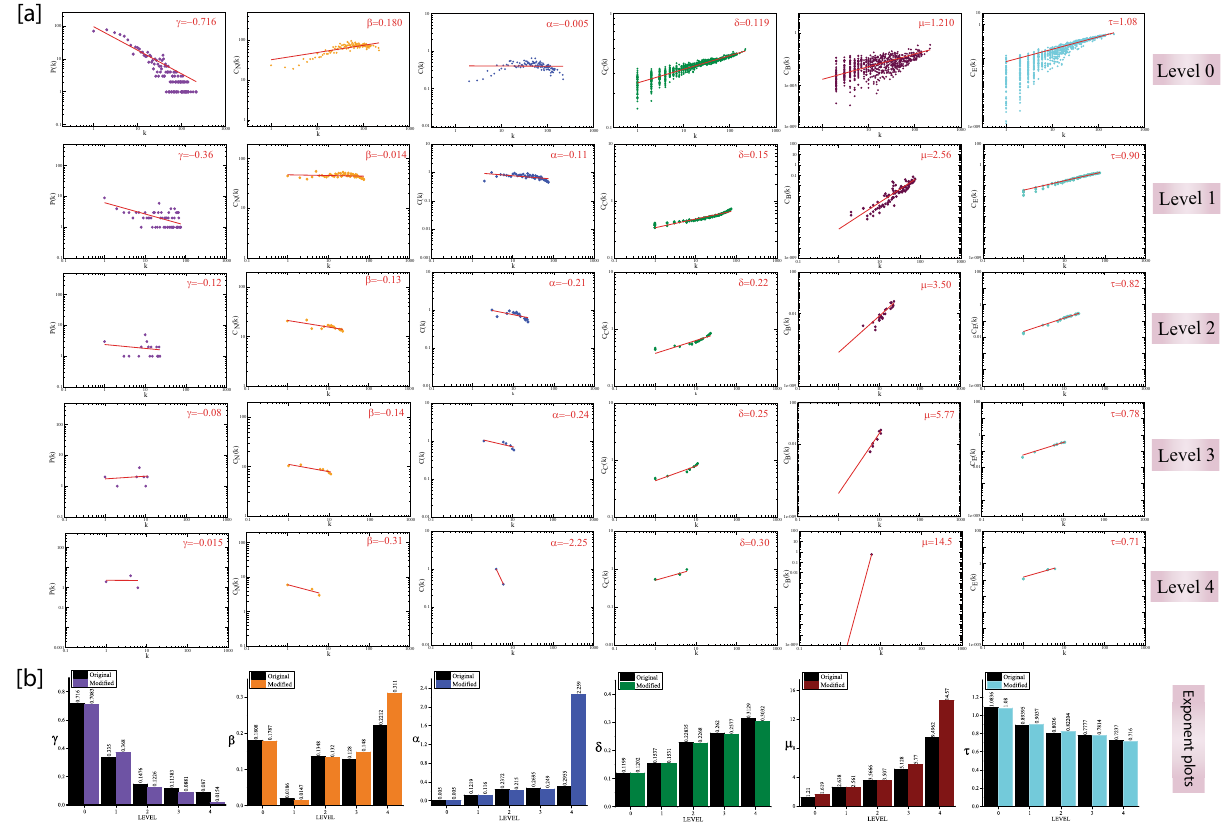
Figure 2. SARC PPI network and sub-networks followed hierarchical scale-free topologies. ( a ) The behaviors of degree distributions P(k), neighborhood connectivity C N (k), clustering co-efficient (k), closeness C C (k), betweenness C B (k) and eigenvector C E (k) measurements as a function with degree k for an original primary network (level 0) and ICOS-CTLA4-GPR29 motif knockout networks at various levels of organization (level 1–4). ( b ) the changes in the exponent values of the six topological properties of the ICOS-CTLA4-GPR29 motif knockout network [colors corresponding to the ones used in the topological properties plots, i.e., violet for P(k), orange for C N (k), blue for C(k), green for C C (k), maroon for C B (k) and cyan for C E (k)] compared with the topological properties’ exponents of the corresponding original networks (black) at various levels of the organization. γ, α, β, δ, µ and τ are the exponents of the degree distribution, neighborhood connectivity, clustering coefficient, closeness centrality, betweenness centrality and eigenvector centrality,